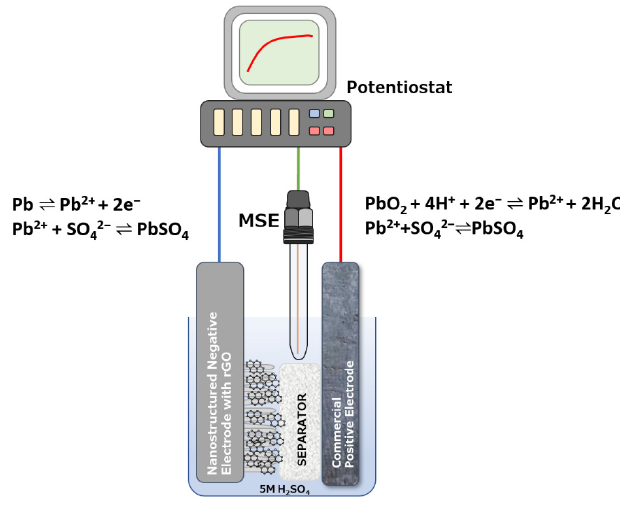
Figure 1. Scheme of nanostructured electrode and battery configuration.